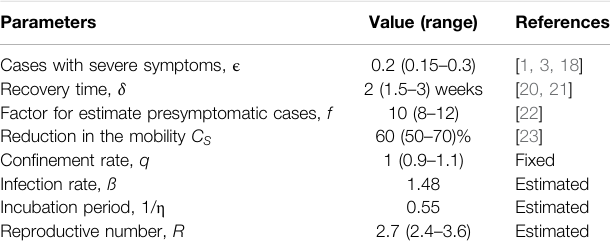
TABLE 1 | Parameters of the sentinel model (1) – 5) for tracking COVID-19 in